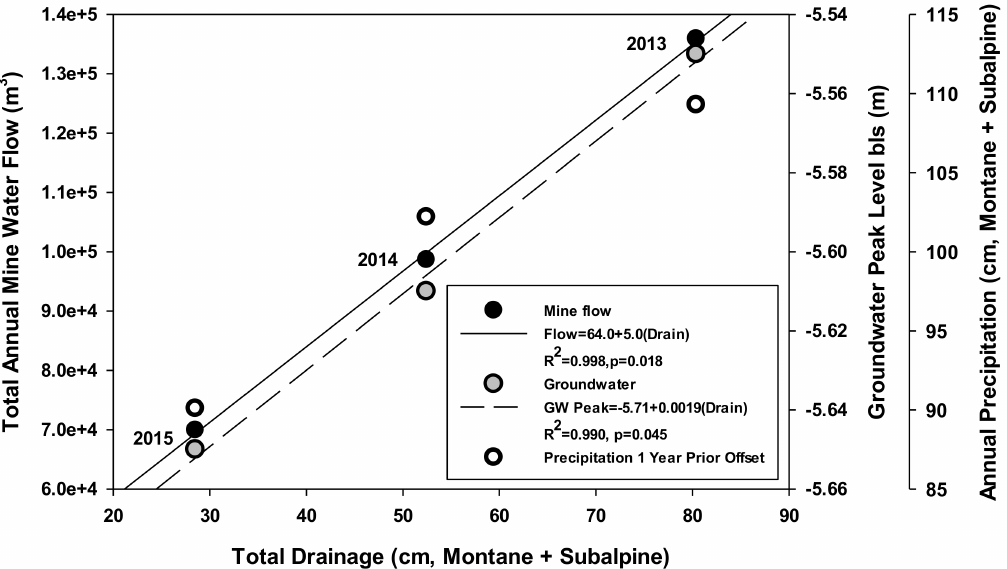
Figure 6. Total annual mine water flow and peak groundwater levels below land surface (Spring Valley) as a function of total drainage from both the Montane West and Subalpine West sites. Total combined annual precipitation with a one-year offset was included for